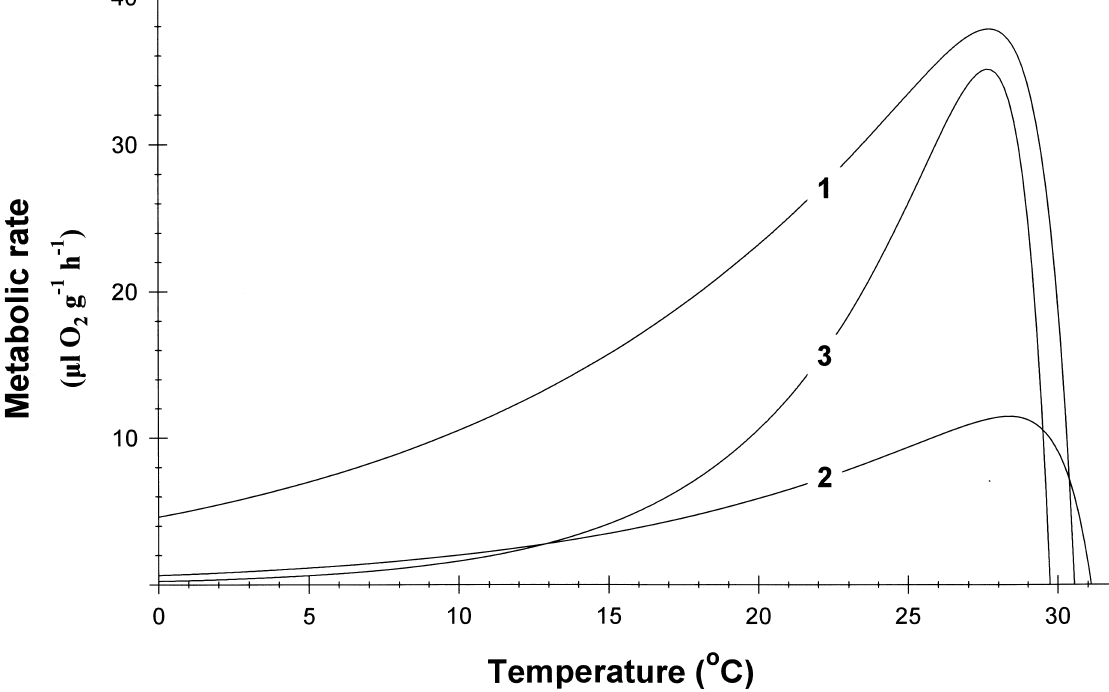
Table 1. Temperature critical points in ° C (for explanations see text) and corresponding metabolic rates in µ l O balcanica at different acclimation regimes. Metabolic rate at 0 ° C is also given, along with optimal temperature range (OTR), Q for several temperature ranges and overall Q